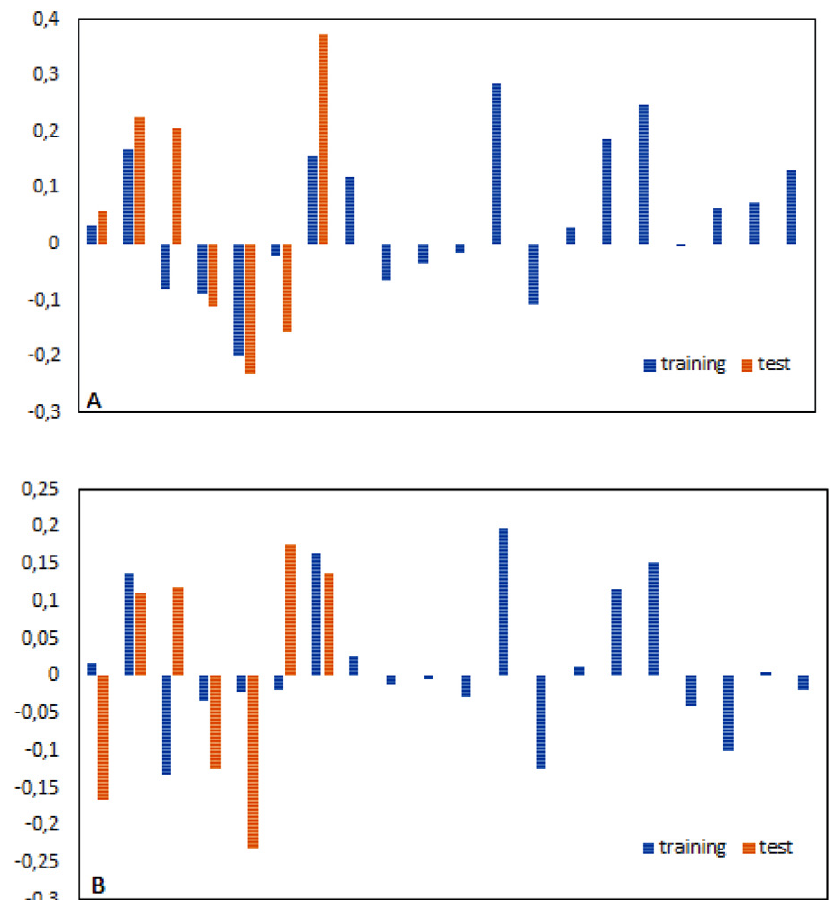
Fig. 4. Histogram of residual values from A) COMFA analysis B) COMSIA